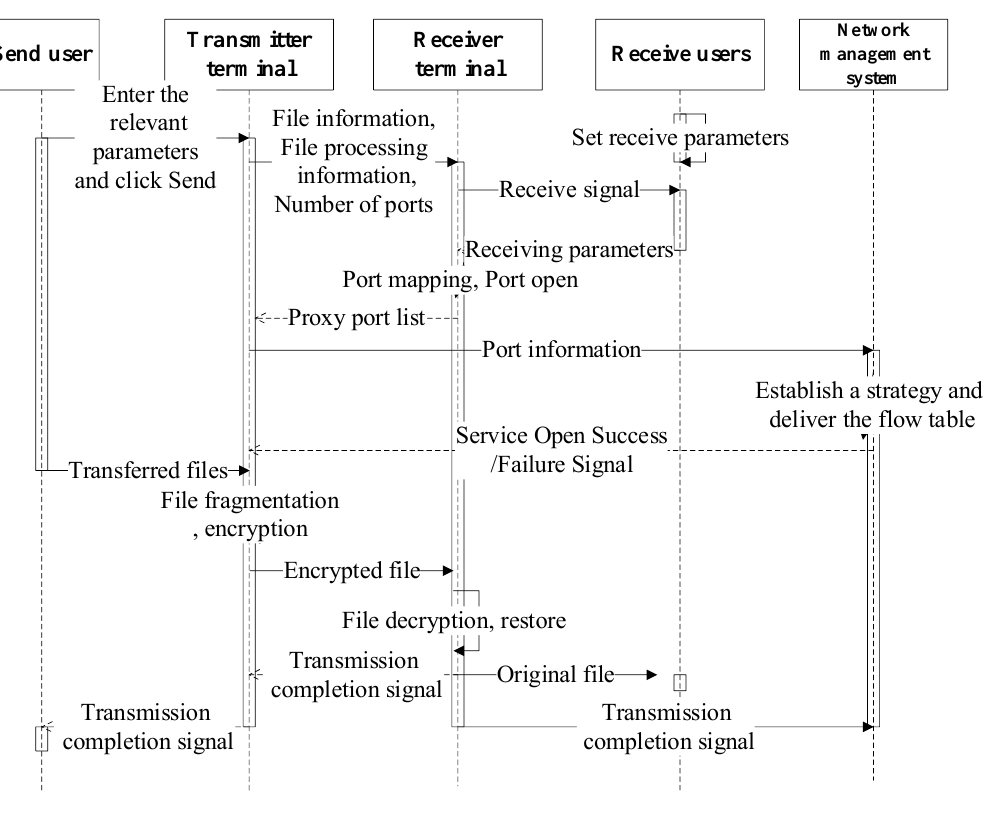
Figure 3. Sequence Diagram of the Sending Process